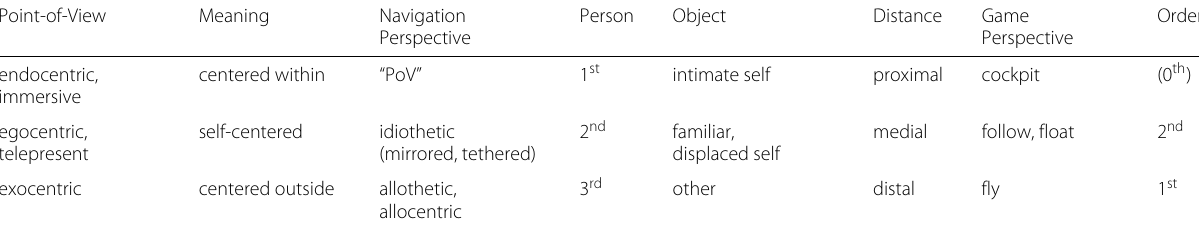
Table 1 Degrees of immersion and virtual perspectives in avatar-populated immersive environments Point-of-View Meaning Navigation Person Object Distance Game Order Perspective Perspective endocentric, centered within “PoV” 1 st intimate self proximal cockpit (0 th ) immersive medial follow, float self-centered idiothetic 2 nd familiar, displaced self (mirrored, tethered)